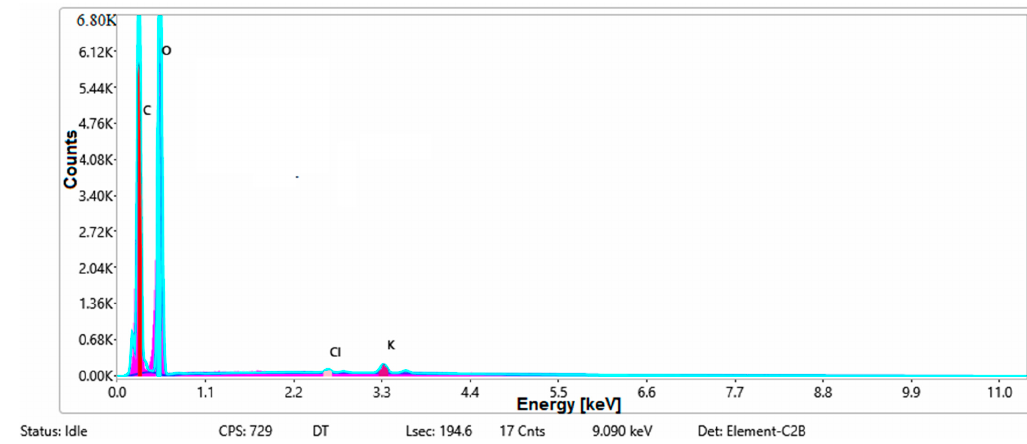
Figure 8. EDS spectra for sample S1 treated in RF plasma O 2 , using RF 2 generator and power 50 W.